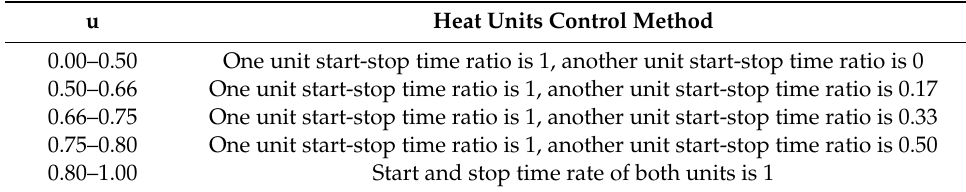
Table 3. Heat units control